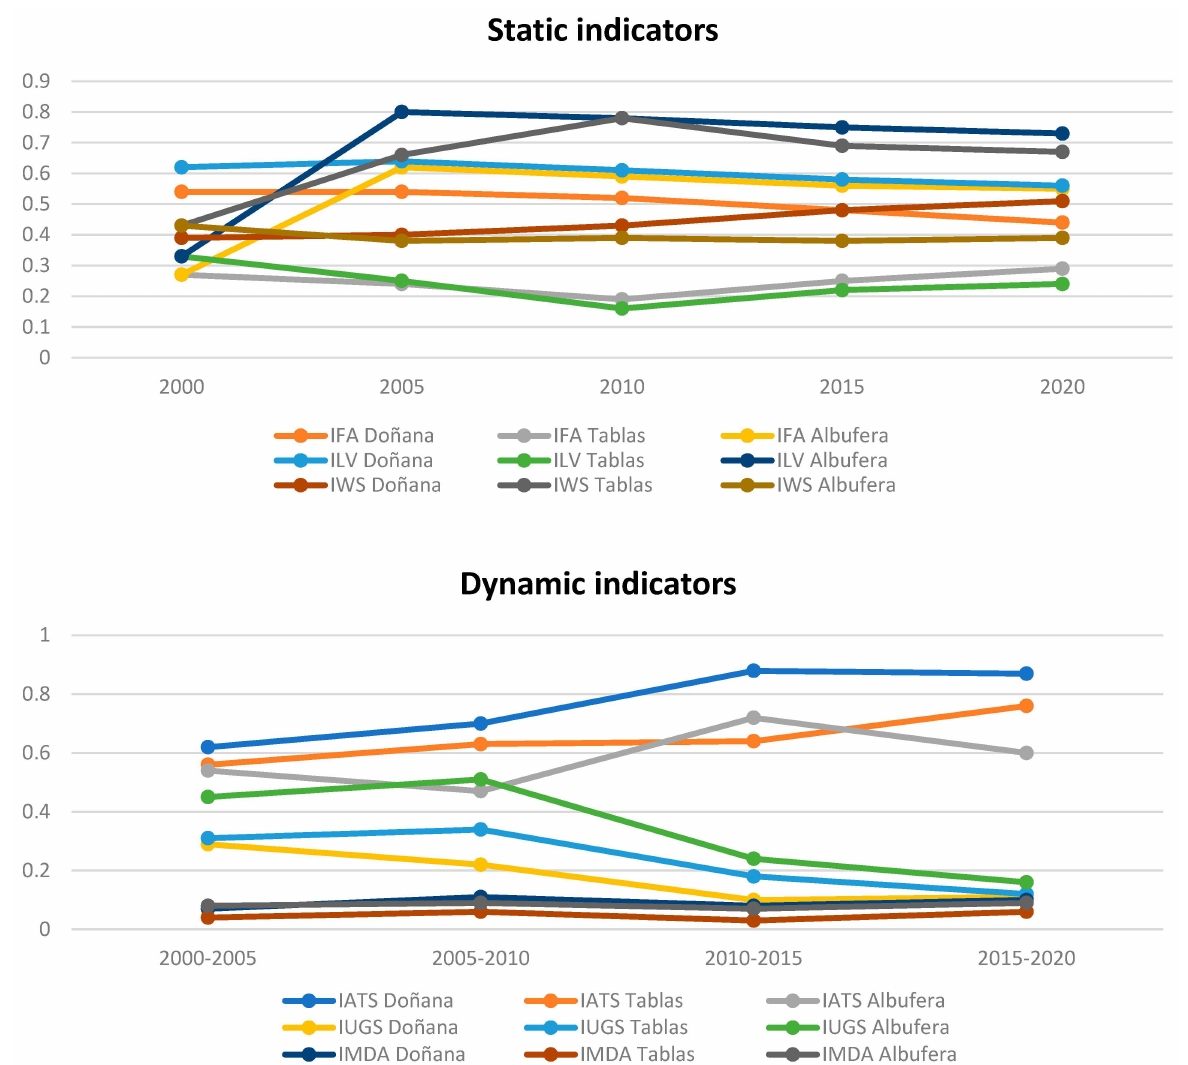
Figure 16. Evolution of static and dynamic GIS indicators for Doñana, Tablas de Daimiel and Albufera of Valencia case studies between 2000 and